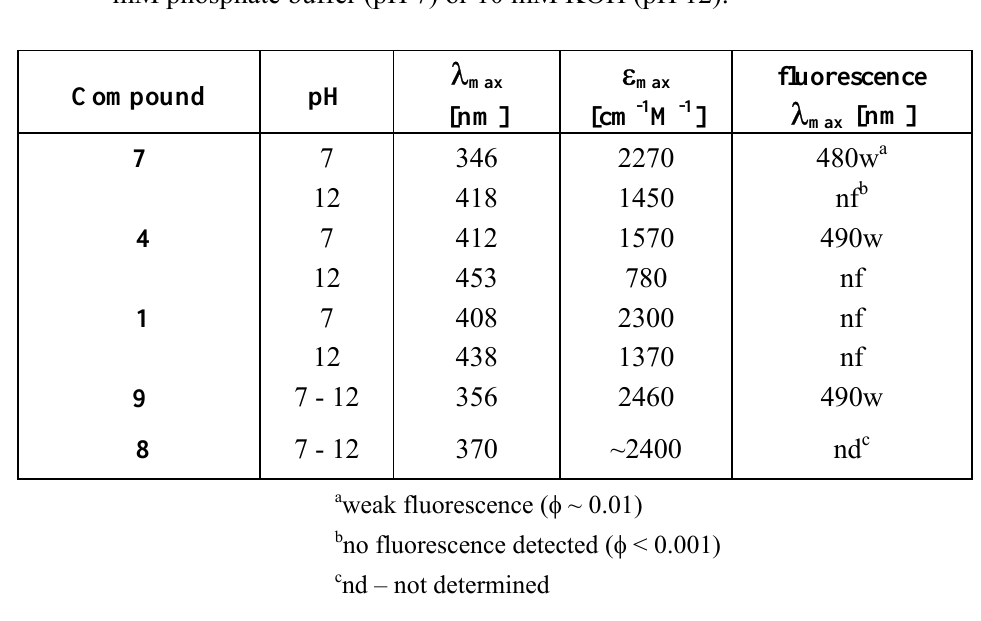
Table 1. Spectral parameters (electronic absorption and/or fluorescence) for selected pyrazolo[4,3-e]-triazines in aqueous solution. Conditions: 50 mM phosphate buffer (pH 7) or 10 mM KOH (pH